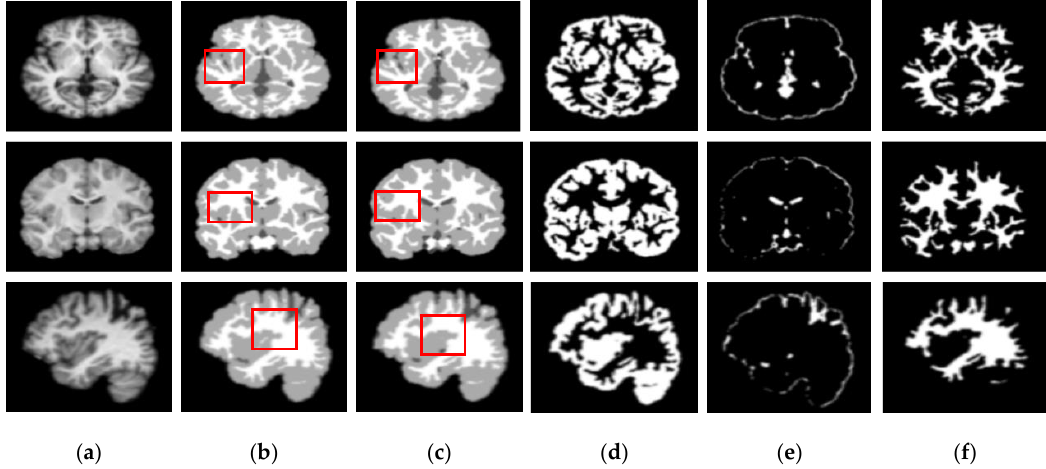
Figure 6. Segmentation results for the axial, coronal, and sagittal planes of the brain MRI image (top to bottom) on the IBSR dataset using the proposed method. ( a ) Original input images, ( b ) ground truth segmentation map, ( c ) their predicted segmentation map obtained by using the proposed method, ( d ) predicted GM (binary map), ( e ) predicted CSF (binary map), ( f ) predicted WM (binary map).